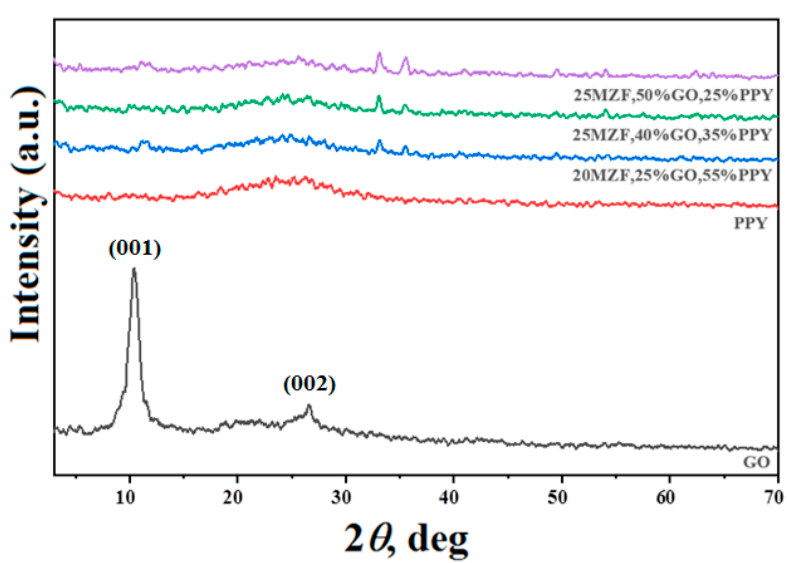
Figure 1. XRD patterns of graphite oxidation product, pure PPy, and PMG composites with different ratios.